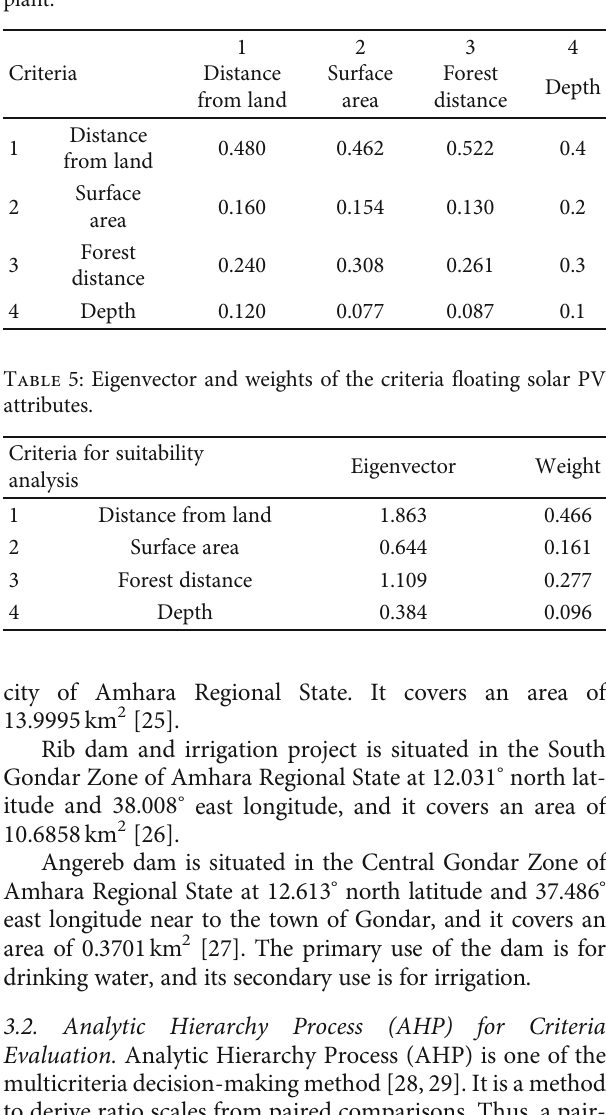
Table 3: Decision maker matrix of fl oating solar PV power plant. Table 4: Normalized decision matrix of fl oating solar PV power